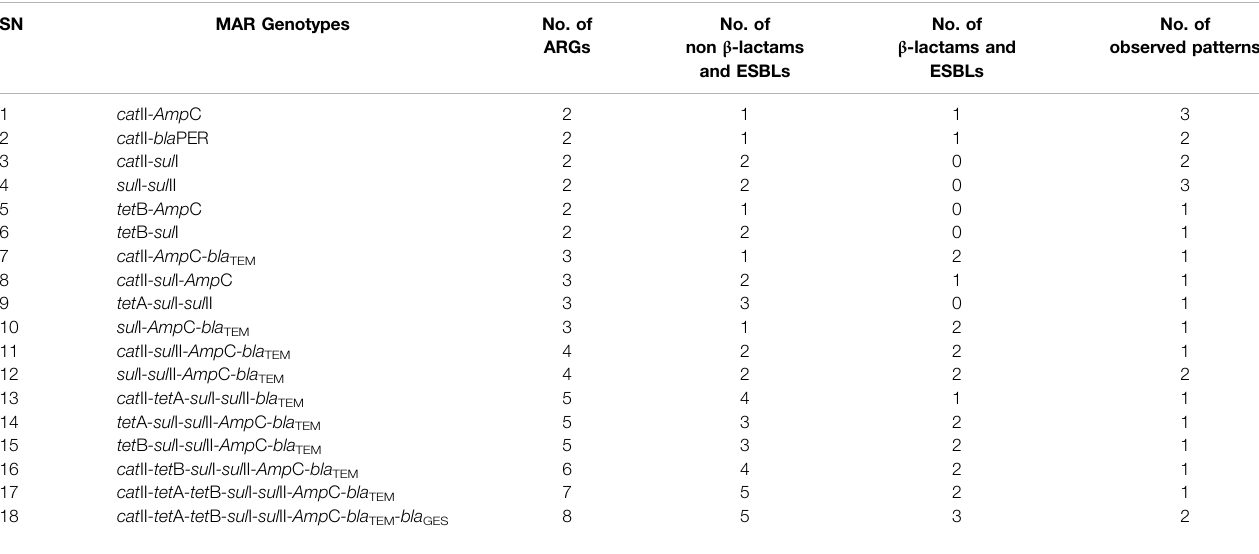
TABLE 4 | The MARGs of the pathogenic strains of E. coli recovered from irrigation